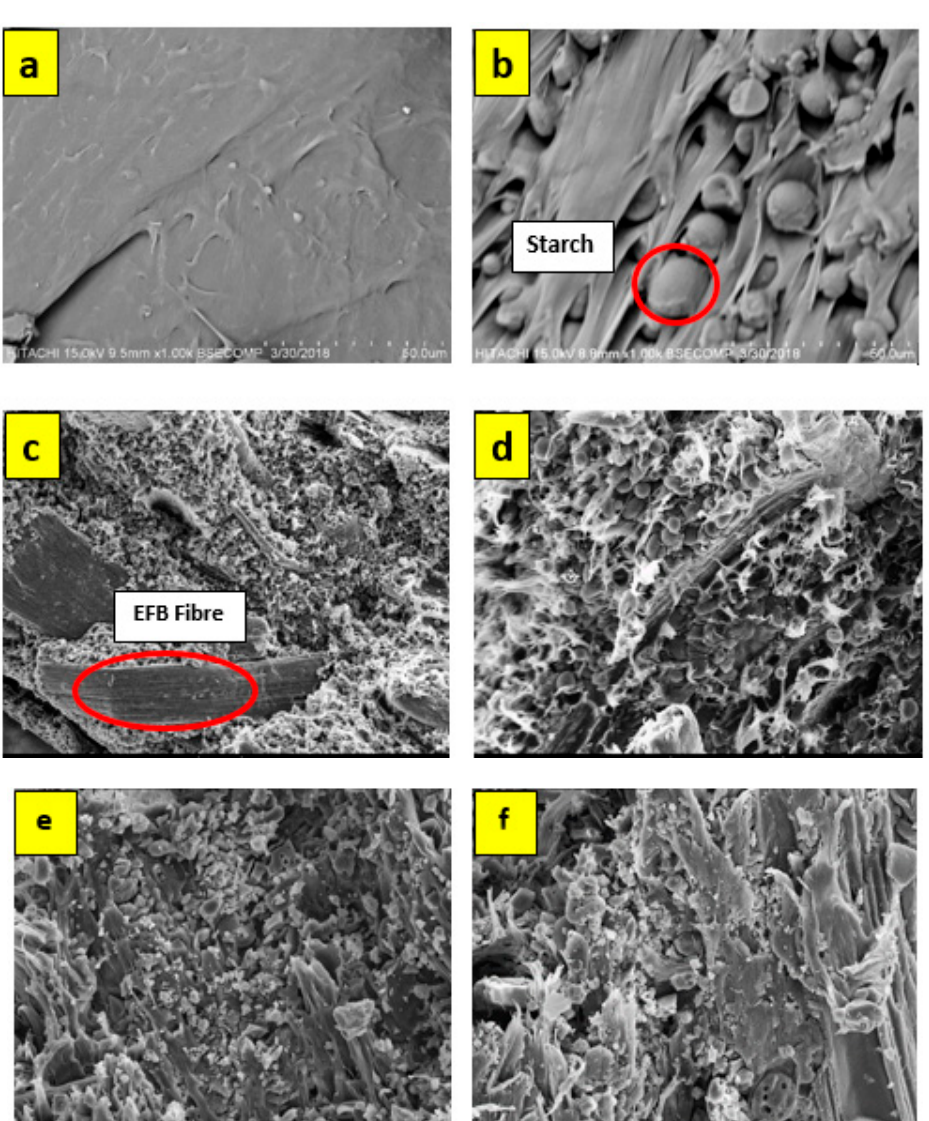
Figure 4. SEM micrographs for: ( a ) raw PBS, ( b ) 0% EFB, ( c ) 8% EFB, ( d ) 12% EFB, ( e ) 16% EFB and ( f ) 20%